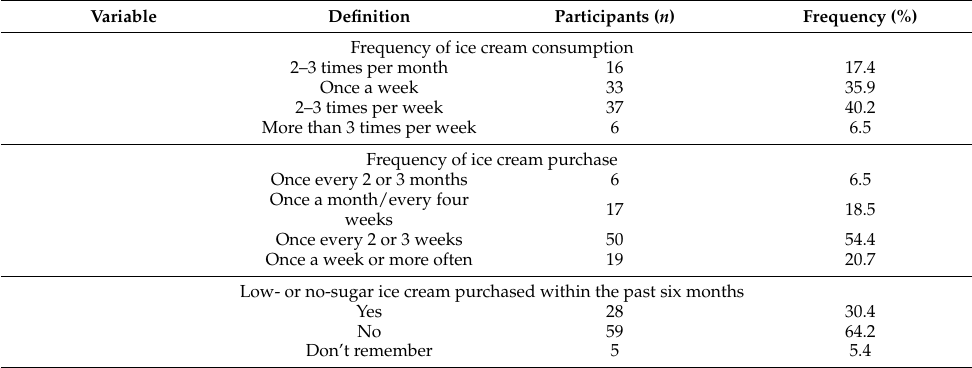
Table 3. Ice cream consumption behaviors by the consumer panel ( n =